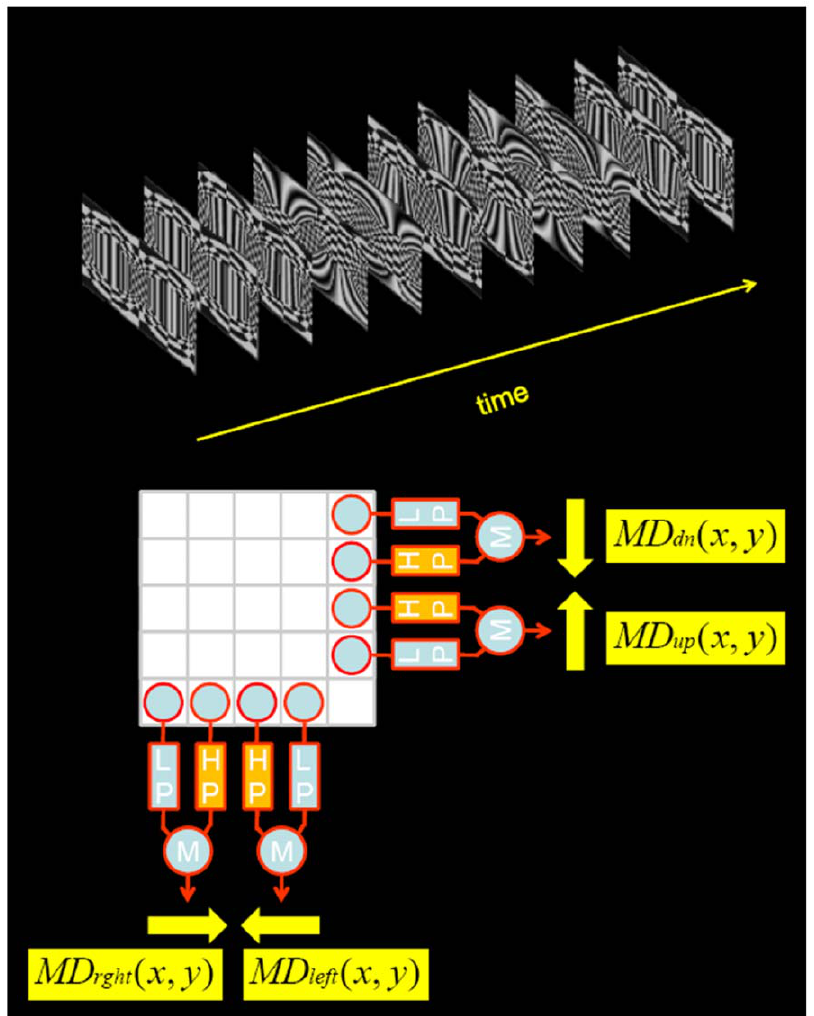
Figure 11. Retinotopic input from local motion detectors. An image sequence is fed onto a retinotopic, two-dimensional array of Reichardt detectors. At each location of the array, 4 different detectors are located: one for rightward, one for leftward, one for downward and one for upward motion. Each detector has one 1st-order low-pass filter and one 1st-order high-pass filter. After passing through the filters, luminance signals of adjacent image pixels become multiplied. The output signals of the multipliers are fed onto the dendritic compartments as conductance values of excitatory and inhibitory synapses, according to the neurons receptive field and preferred orientation.